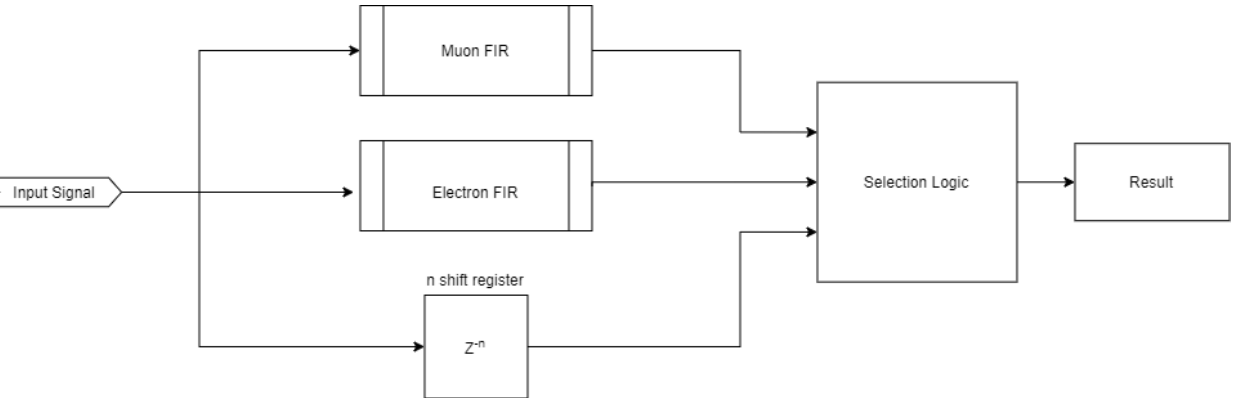
Figure 13. Block diagram of FIR-based correlation pulse